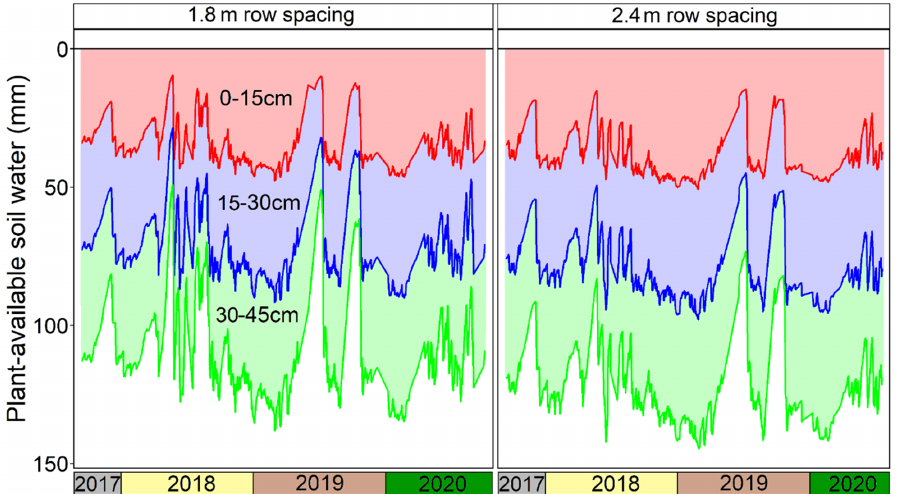
Figure 4. Plant − available water between 1.8 and 2.4 − foot row spacing from September 2017 through September 2020. Plant − available water is soil moisture above a matric potential of − 1.5 MPa. The total water available in the top 45 cm of soil is represented by the green light. The available water in each soil layer is represented by the shaded area between the lines. The plow pan in the soil was at the same depth in both 1.8 and 2.4 m row spacing plots, but the mean pressure required to insert the probe was greater in the plots with 1.8 m rows (Figure 5). The plow pan was at a mean depth of 22.5 ± 0.98 and 23.5 ± 1.5 cm below the bottom of the furrow (49.4 ± 0.46 and 38.2 ± 0.56 cm from the top of the row) in the 1.8 and 2.4 m rows, respectively. The mean pressure required to insert the probe was 4321 ± 170 and 3032 ± 152 kPa for the 1.8 and 2.4 m rows spacing plots, respectively. Oth- erwise, the shape of the pressure curve relative to soil depth was similar between row spacings. The relationship between depth and insertion pressure of the maximum com- pacted layer was not related to VWC and PAW in any layer or the sum of the soil layers. The compacted layer was not related to variety or plot.